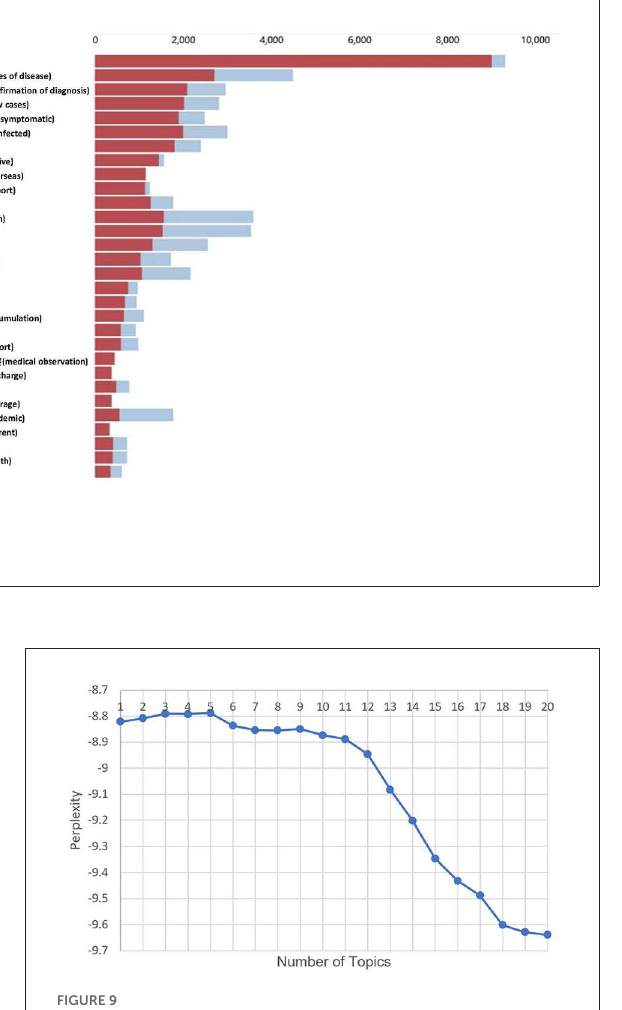
FIGURE9 Relationship between the number of topics and the perplexity in disgust